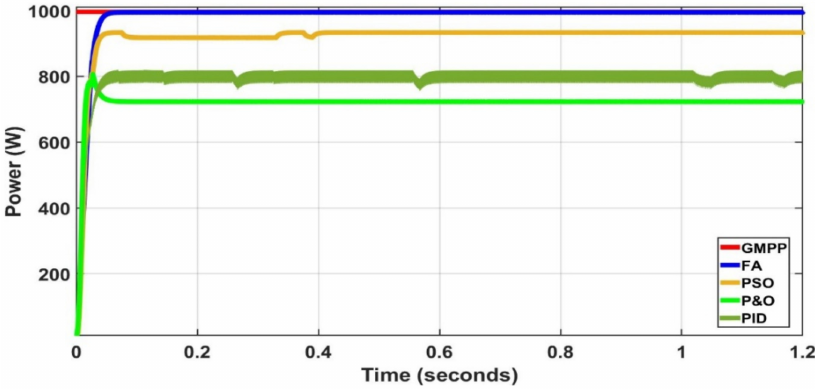
Figure 24. Comparison of FA with PSO, P&O and PID